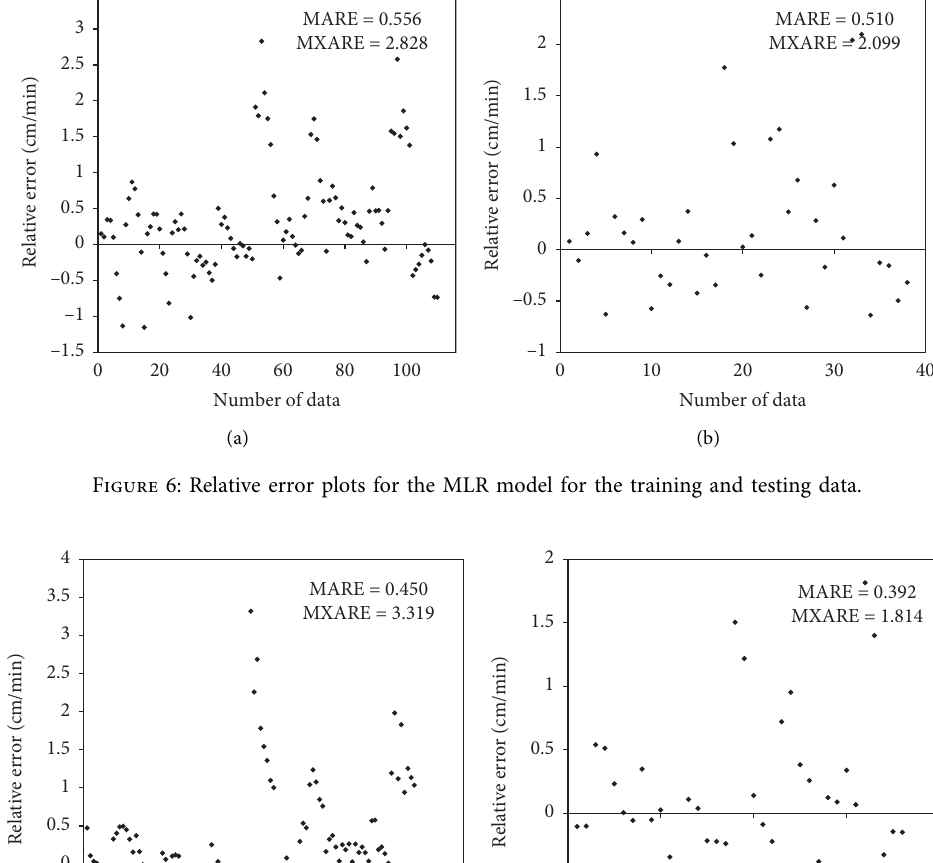
Figure 7: Relative Error plots for the GRG model for the training and testing data.